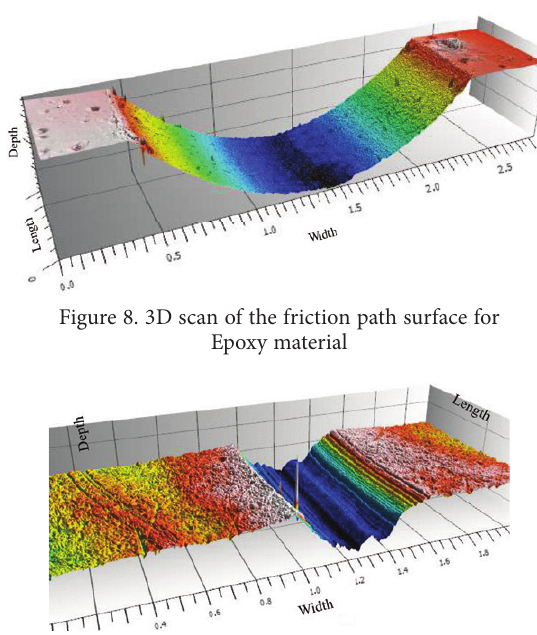
Figure 9. 3D scan of the friction path surface for F180